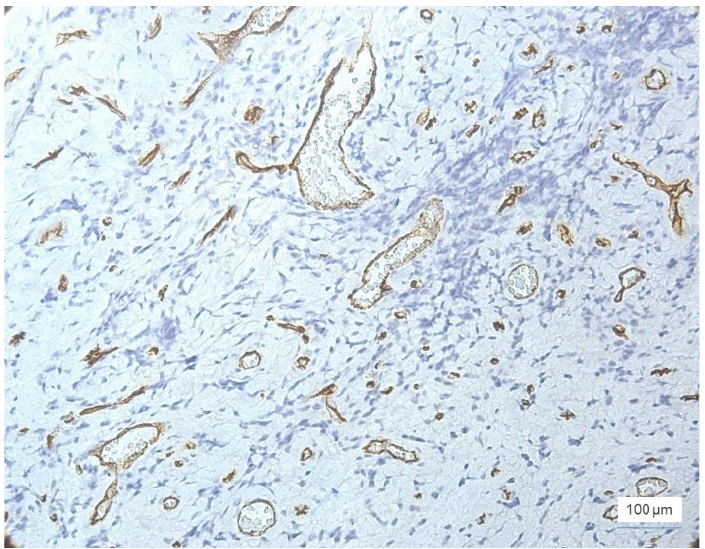
Figure 3. Severe inflammation marked vascular polymorphism, small vessels with or without lumen narrow, anti-CD34 immunohistochemical staining, and DAB chromogen, ×100 magnification. Small narrow-lumen vessels have been observed in large amounts in gingival lesions with moderate and severe inflammation. In the cases of severe inflammation, vascular structures in the form of cords with a tendency to form a lumen were encountered. Most cases with severe inflammation showed extensive areas of bleeding. In these cases, we identified large dilated vessels with dilated stasis and numerous branches, suggesting the activation of endothelial cells (Figure 4).